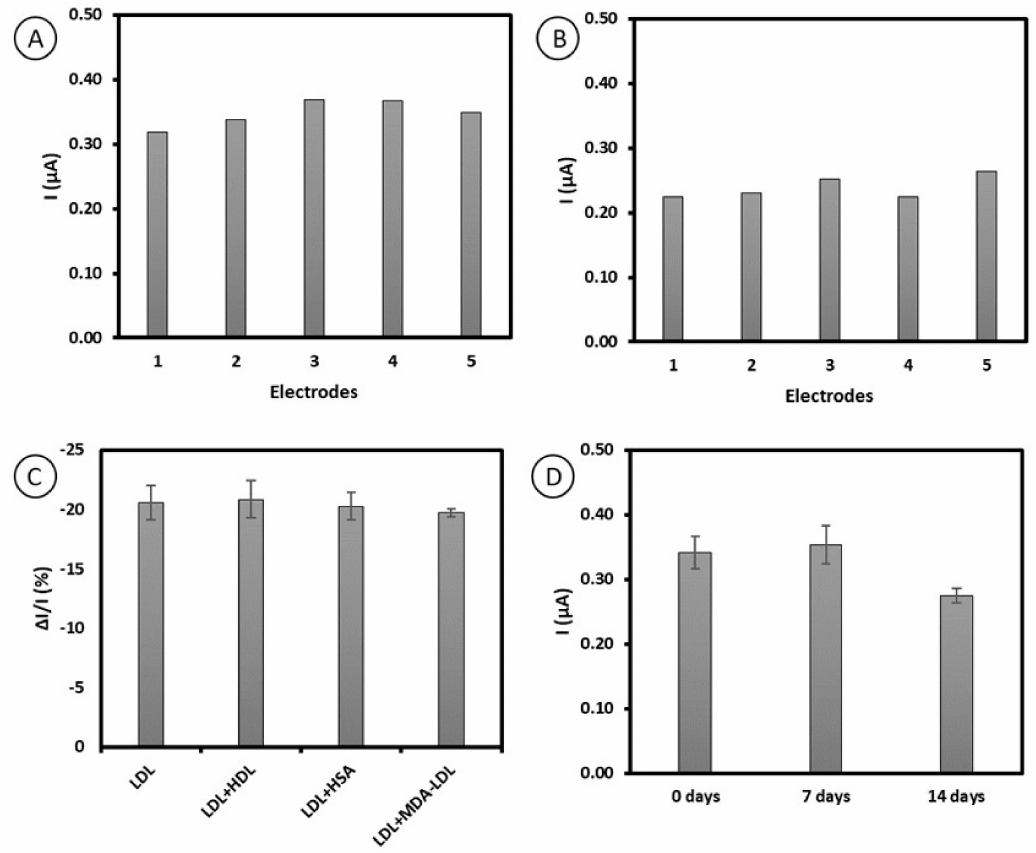
Figure 5. Results of ( A ) reproducibility, ( B ) repeatability, ( C ) selectivity of immunosensor with 0.01 ng/mL LDL with different interferents at a concentration of 0.5 ng/mL (high-density lipoprotein (HDL), human serum albumin (HSA), and malondialdehyde-modified low-density lipoprotein (MDA-LDL)), and ( D ) stability studies registered within 14 days, obtained for the platform based on antibody–ferrocene